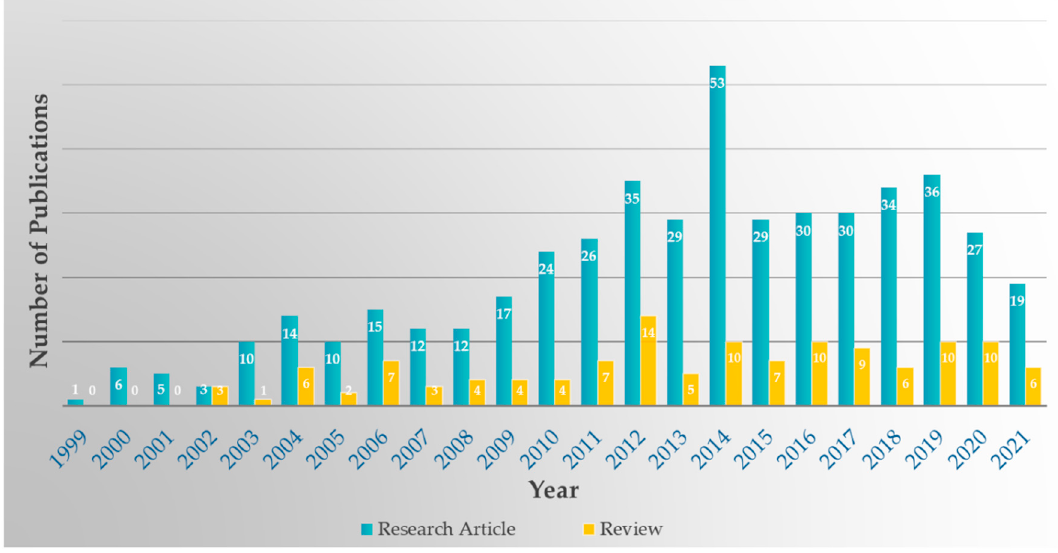
Figure 2. Publications (research articles and reviews) reporting the activity of natural products on CYP450s.